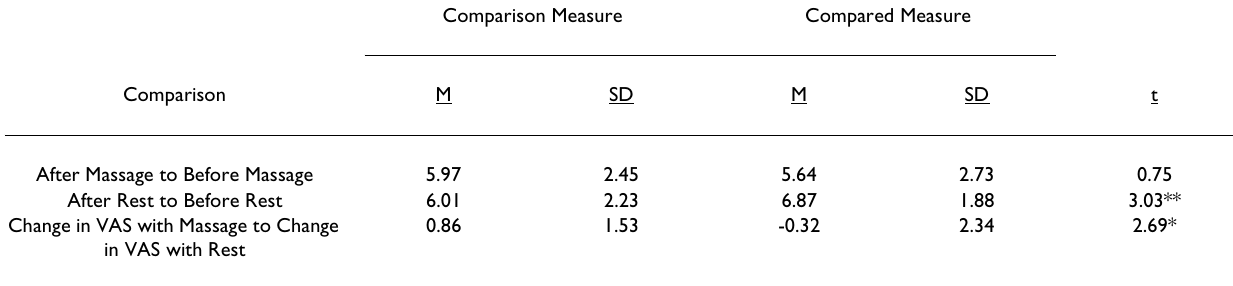
Table 5: Summary of Visual Analogue Scale (N = 29)